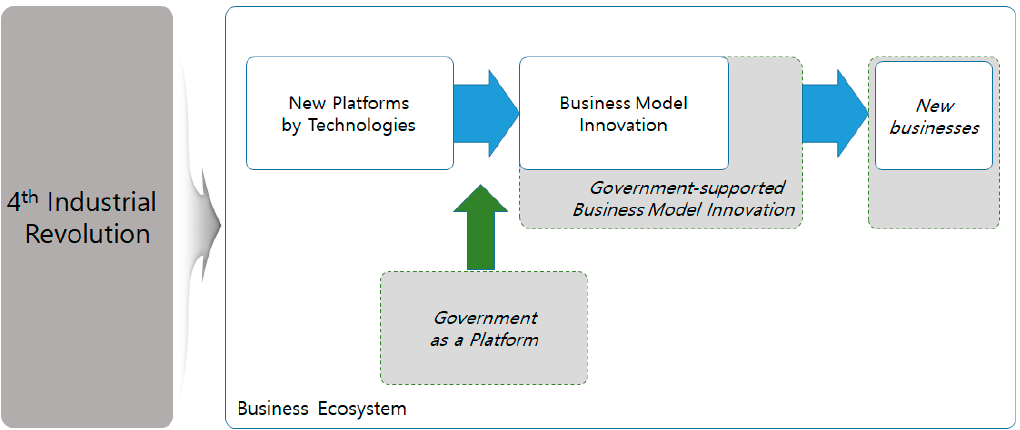
Figure 2. Expansion of possibilities for business model innovation and new business by government support.